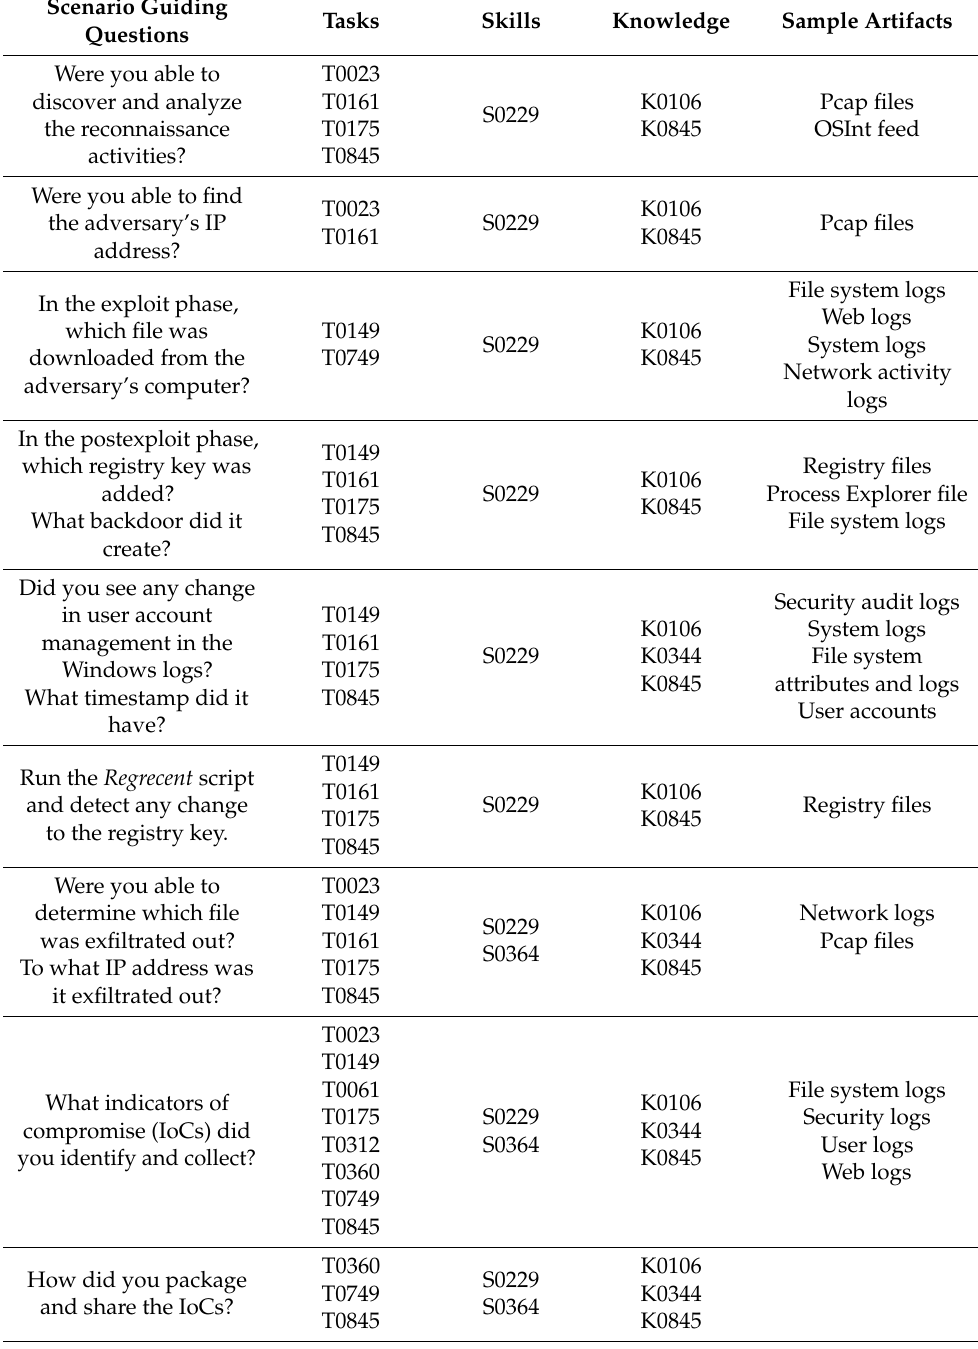
Table 4. Assessing KSAs and Competencies from Various Scenarios—Competency: Threat Intelli- gence